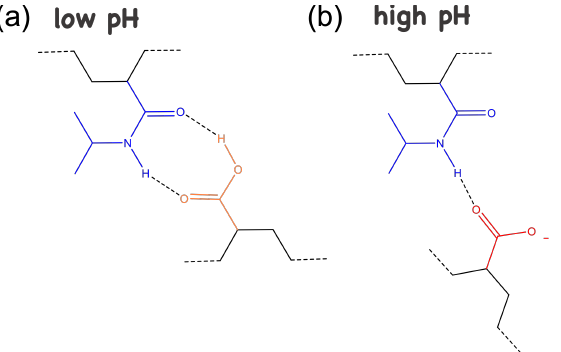
Figure 6. Sketch of the PNIPAM-PAAc interactions: ( a ) at low pH, when the carboxylic groups (COOH, in orange) of AAc are protonated, the formation of complexions with the amide groups (CONH, in blue) of NIPAM occurs, through two hydrogen bonds (dashed black lines); ( b ) at high pH, the AAc carboxylic groups are deprotonated (COO − , in red) and a single hydrogen bond may form with